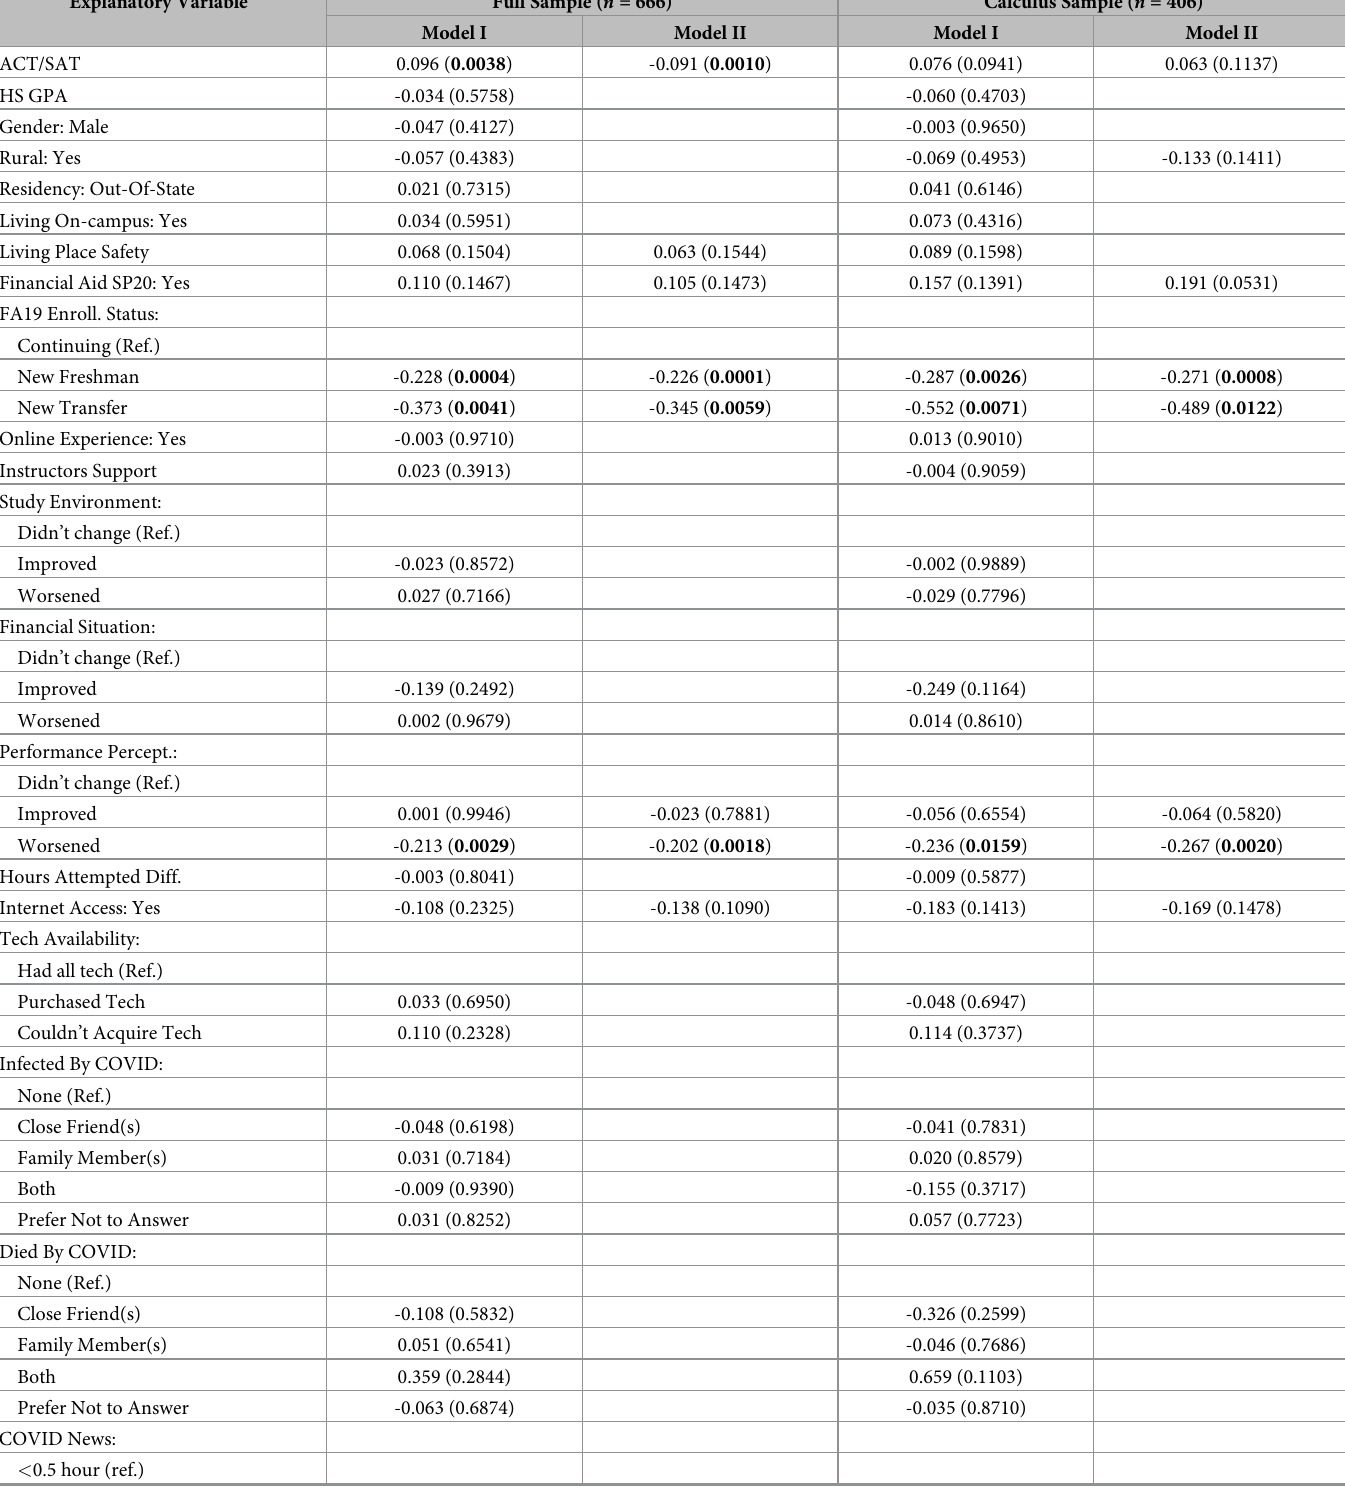
Table 2. Results of regression modeling [coefficient (p-value)] for change in GPA (before vs. during